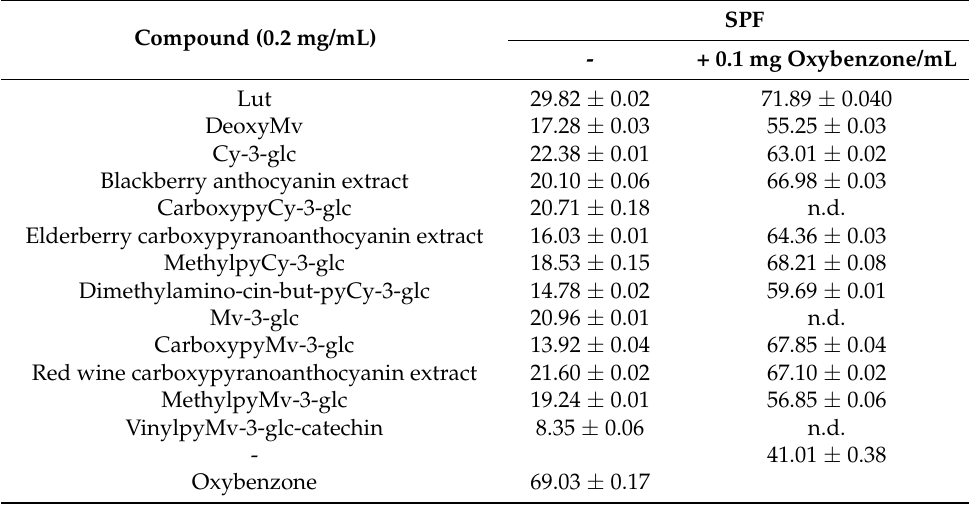
Table 3. In vitro solar protection factors (SPF) of anthocyanins and derivatives estimated in the absence and presence of